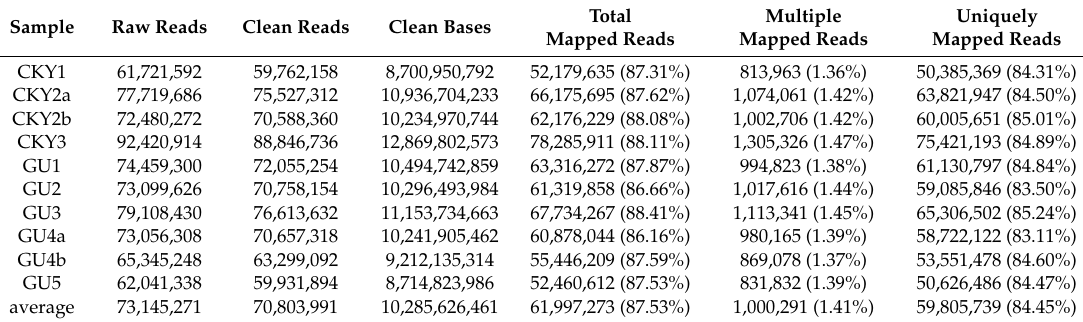
Table 1. Summary of the transcripts in horse testicular tissues.